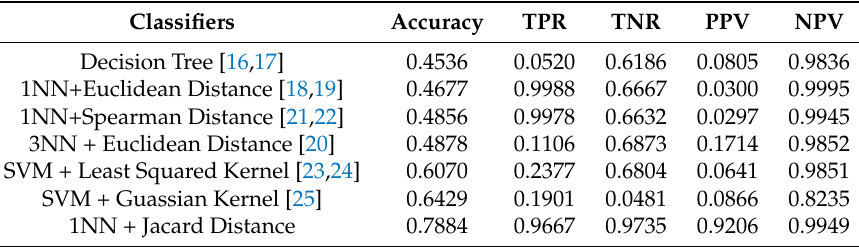
Table 1. Comparison of results obtained from different ML